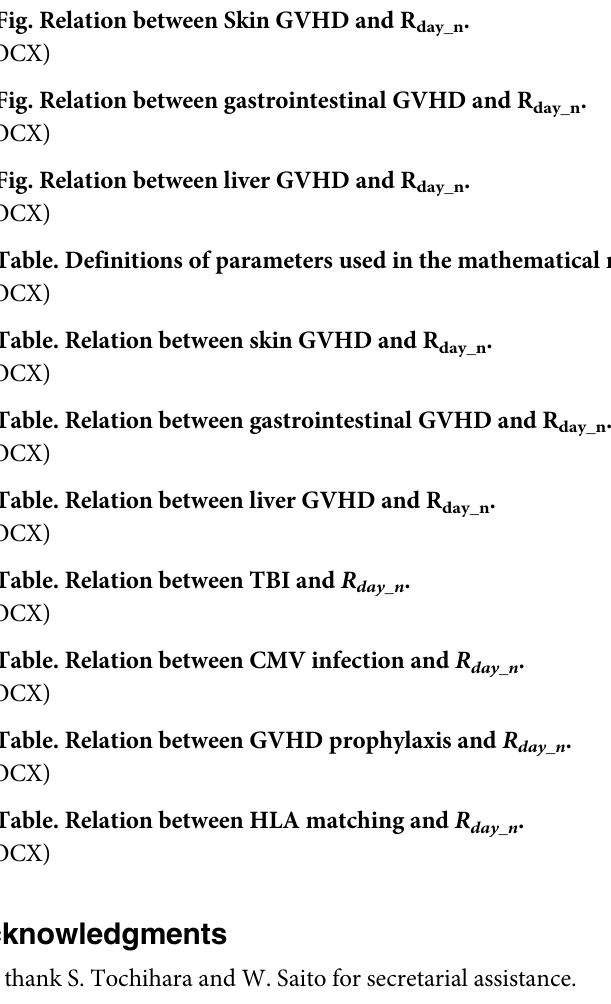
. day_n . day_n . day_n . day_n . day_n . day_n . day_n . day_n day_n